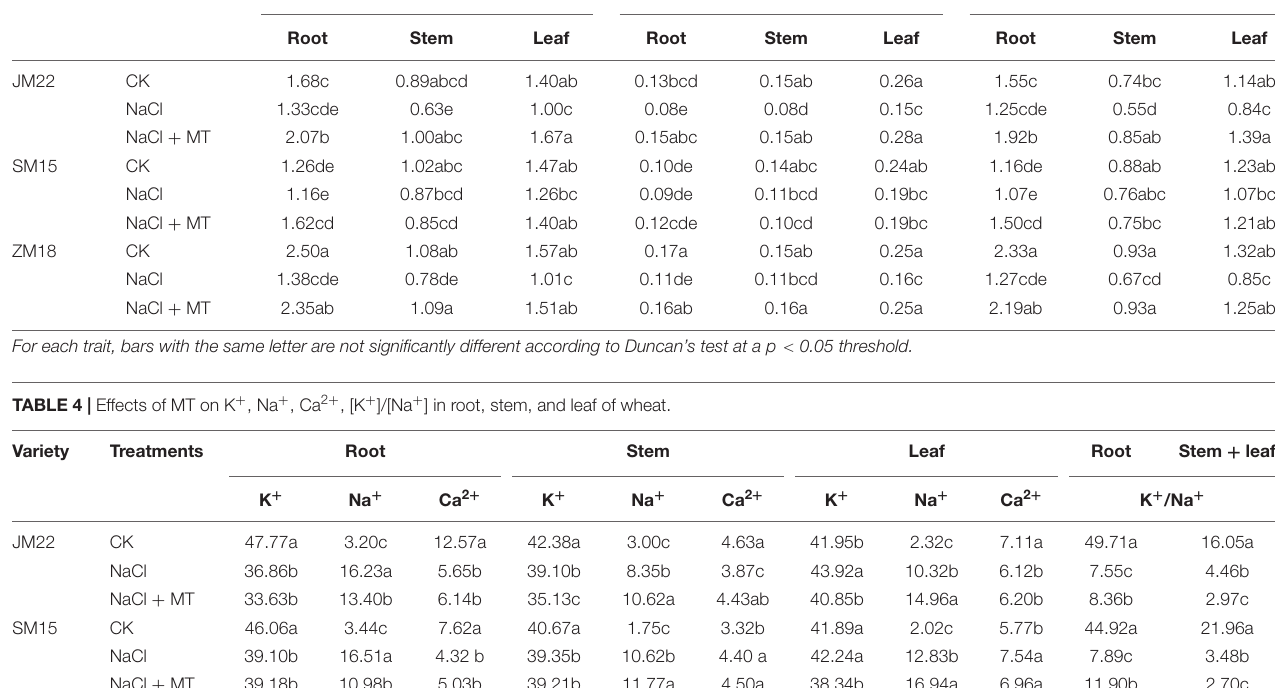
TABLE 3 | Effects of MT on fresh weight and dry weight of root, stem, and leaf of wheat under salt stress. Variety Treatments